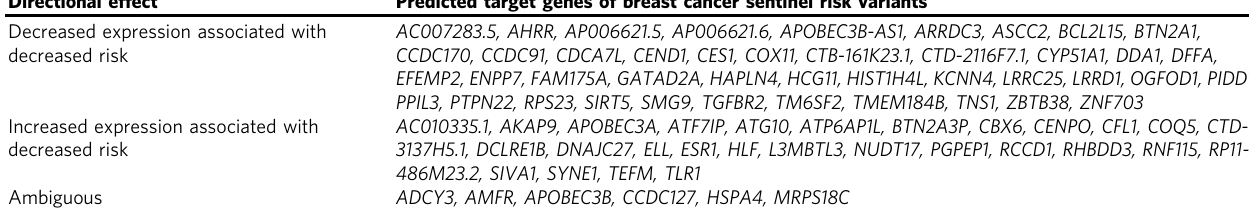
Table 1 Directional effect of genetically determined gene expression on disease risk for predicted target genes of breast cancer sentinel risk